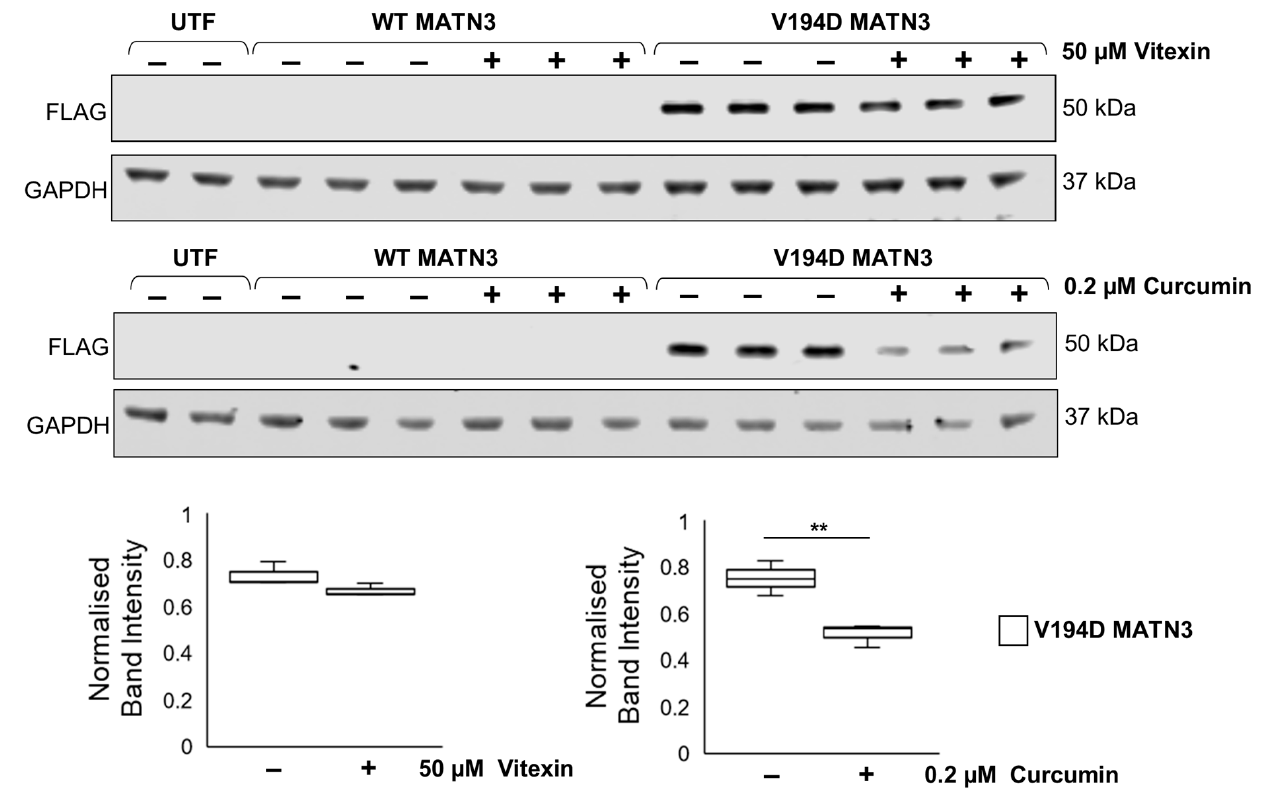
Figure 3. Curcumin treatment reduces the intracellular accumulation of mutant matrilin-3. WT and V194D mutant MATN3-expressing HELA cells were cultured in the presence/absence of either 50 µ M vitexin or 0.2 µ M curcumin for 48 h and the intracellular expression of FLAG-tagged matrilin-3 was analysed by Western blotting. Wild-type matrilin-3 was secreted from the cell and so was not detected in the cell lysate, however, V194D mutant matrilin-3 was retained intracellularly. Although vitexin has no effect on intracellular protein expression, curcumin treatment significantly reduces the accumulation of intracellular mutant matrilin-3. (Equal loading shown by GAPDH. FLAG: FLAG-tagged matrilin-3, GAPDH: glyceraldehyde-3-phosphate dehydrogenase, MATN3: matrilin-3, WT: wild-type, UTF: untransfected, ** p < 0.005, n = 3).